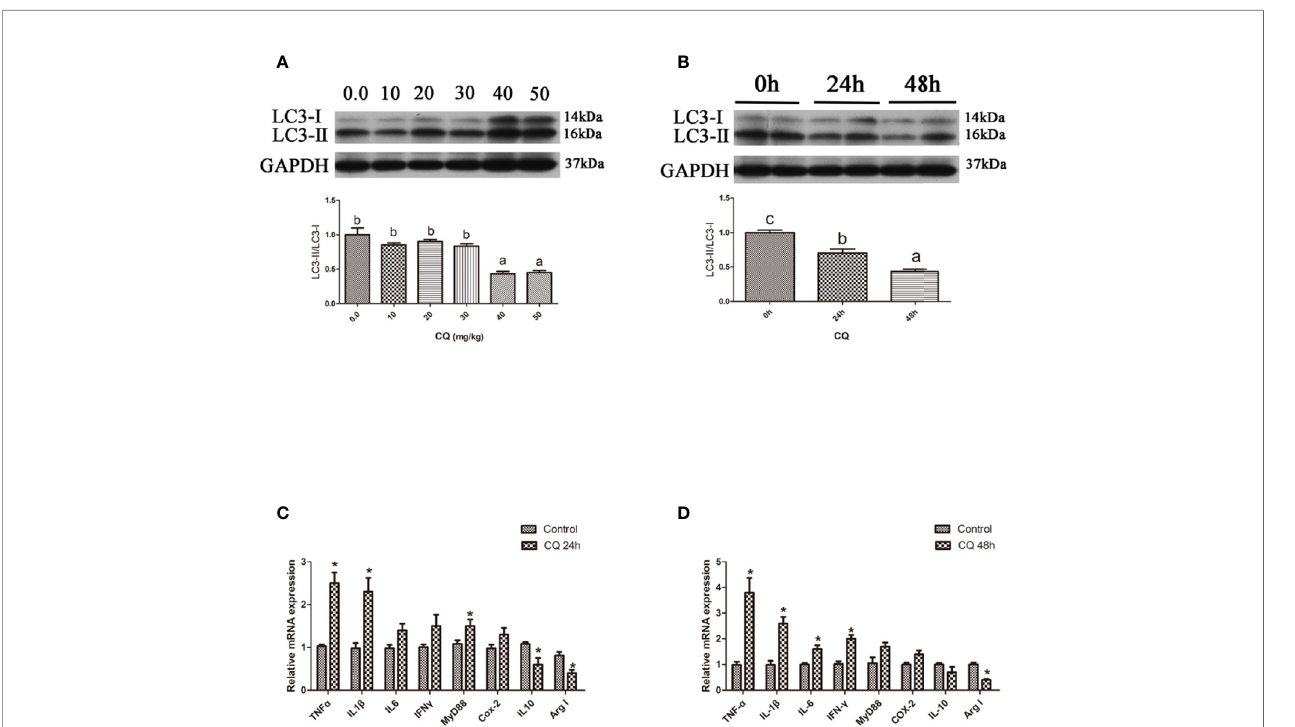
FIGURE 3 | Inhibition of autophagy could up-regulate the expression of in fl ammatory genes in vivo . (A) The ratio of LC3-II/LC3-I was analyzed by western blots on liver after treatment of different levels of CQ (n=3). (B) The ratio of LC3-II/LC3-I was analyzed by western blots on liver after treatment of different time of CQ (n=3). (C) The mRNA expressions of TNF a , IL1 b , IL6, IFN g , MyD88, Cox-2, IL10 and Arg I were analyzed by qRT-PCR on liver after injected with 40 mg/kg CQ for 24h (n=6). (D) The mRNA expressions of TNF a , IL1 b , IL6, IFN g , MyD88, Cox-2, IL10 and Arg I were analyzed by qRT-PCR on liver after injected with 40 mg/kg CQ for 48h (n=6). Results were represented as means with SEM and signi fi cance was evaluated by one-way ANOVA followed by Tukey ’ s multiple range tests or independent t tests (* P < 0.05). a,b,c Means share a same superscript letter are not signi fi cantly different ( P ≥